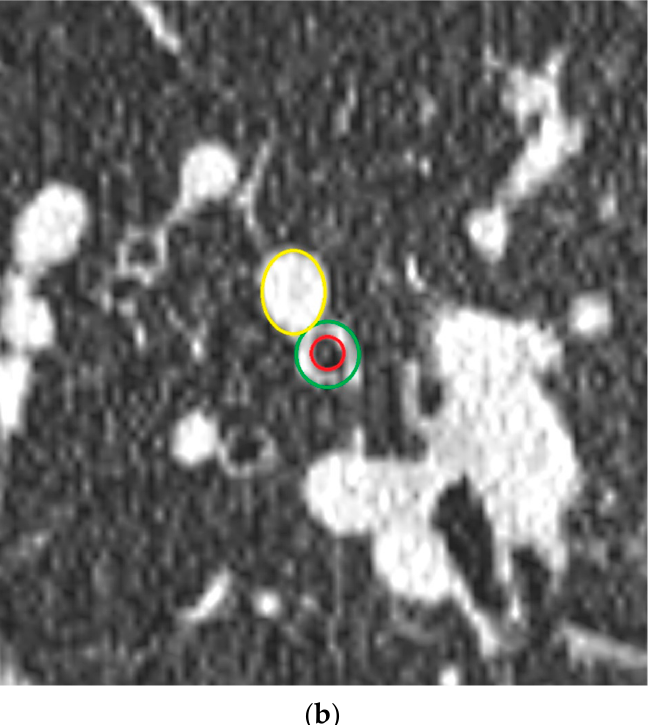
Figure 3. CT Airway measurement example. ( a ) is an example of segmented 3D volume rendered image of the bronchial tree generated from the CT data by SyngoVia image post processing software, with the segmental airway branches in various shades of green and blue. The red line signifies the bronchopulmonary segmental airway being measured in Figure 1b (left lower lobe lateral segment). ( b ) shows a corresponding multiplanar reformat image of the left lower lobe lateral segmental bronchus, double oblique to the centreline of the airway. Automated inner (red) and outer (green) airway area measurements are shown, along with measurement of the adjacent artery area (yellow).